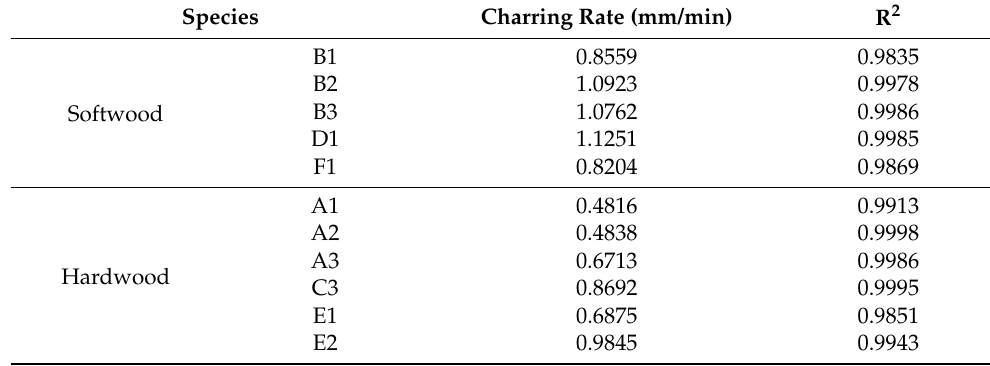
Table 5. Basic charring rates of samples.